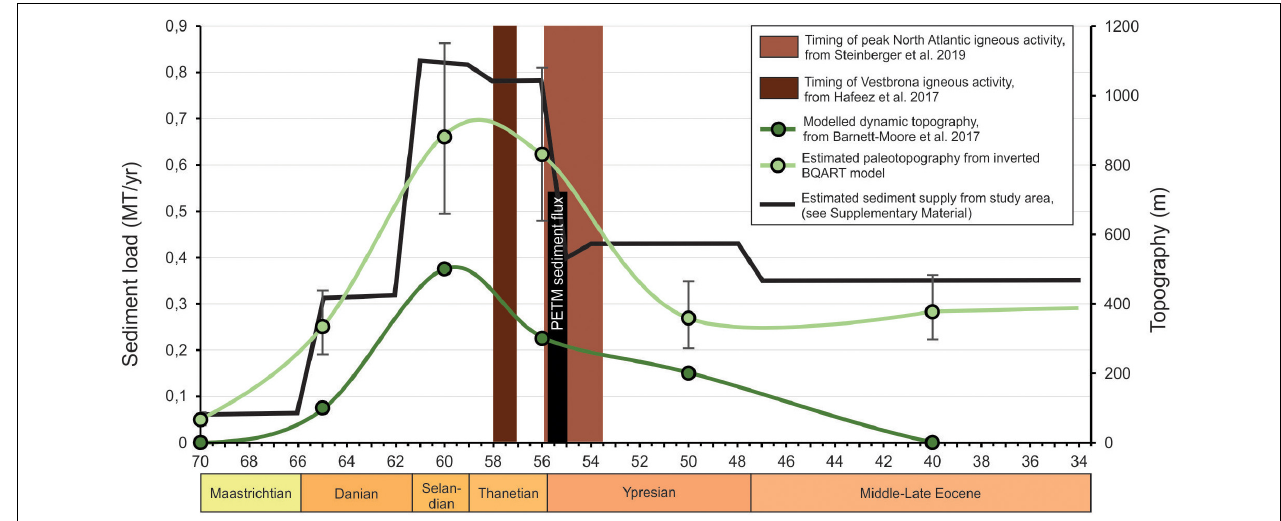
FIGURE 10 | Plot showing calculated sediment supply and estimated paleotopography from this study together with predicted dynamic topography (uncertainty range ± 5 Myr) and magmatic intensity in the North Atlantic Igneous Province. Also shown is the estimated PETM sediment supply from this study. Maximum forced regression occurred around the PETM and coincides with the timing of peak volcanic activity in the North Atlantic and just after the Vestbrona volcanics ( Figure 1